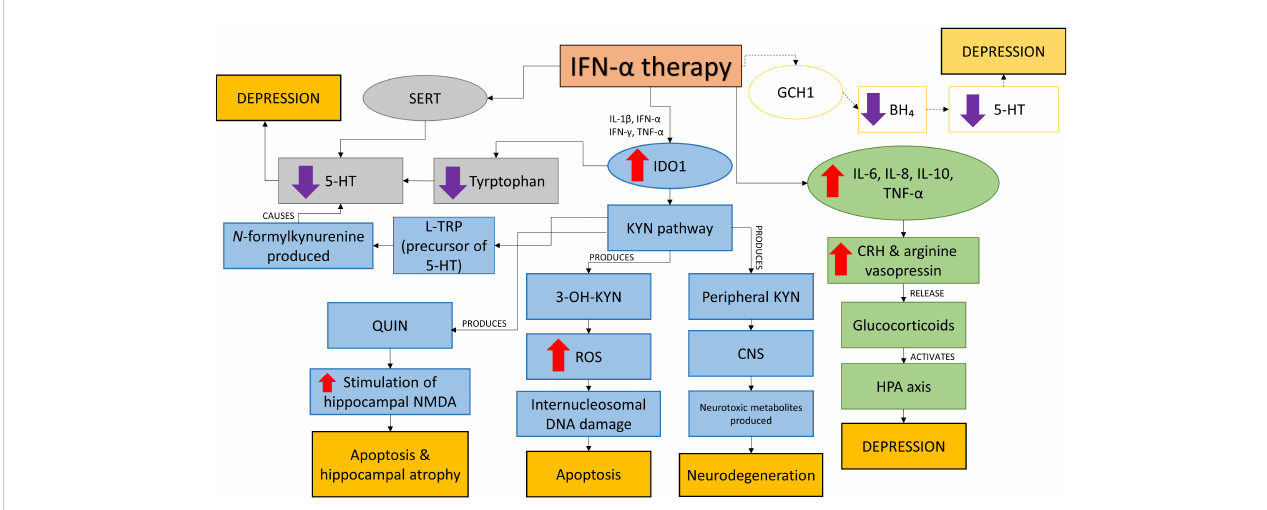
FIGURE 2 The effects of IFN- a therapy. IFN- a disrupts IDO1, SERT and possibly GCH1 systems and HPA axis leading to neurological changes and depression. Lower 5-HT production which is linked to depression is caused by the disruption on the SERT and IDO1 systems. IFN- also causes apoptosis, hippocampal atrophy and neurodegeneration via the KYN pathway as a result of increased IDO1 by (i) inhibiting the conversion of L-TRP, precursor of 5- HT (ii) production of QUIN which increases the stimulation of hippocampal NMDA (iii) production of 3-OH-KYN leading to increased ROS production causing intranucleosomal DNA damages and (iv) production of peripheral KYN which affects the CNS and subsequently neurodegeneration due to the release of neurotoxic metabolites. IFN- therapy also increases the production of pro-in fl ammatory cytokines which activate the HPA axis and causes depression. Another possible target of IFN- a is on GCH1 which reduces BH4 production, reducing 5-HT and leads to depression. IFN- a , Interferon- alpha; IL-1 b , Interleukin-1beta; IFN- g , Interferon-gamma; TNF- a , TNF-alpha; 5-HT, Serotonin; SERT, Serotonin transporter; IDO1, Indoleamine 2,3 dioxygenase; KYN, Kynurenine; 3-OH-KYN, 3-hydroxy-kynurenine; QUIN, Quinolinic acid; NMDA, N-methyl-D-aspartate; CNS, Central nervous system; ROS, Reactive oxygen species; BH ₄ , Tetrahydrobiopterin; CRH, Corticotropin-releasing hormone; HPA, Hypothalamic-pituitary-adrenal; GCH1, GTP cyclohydrolase I